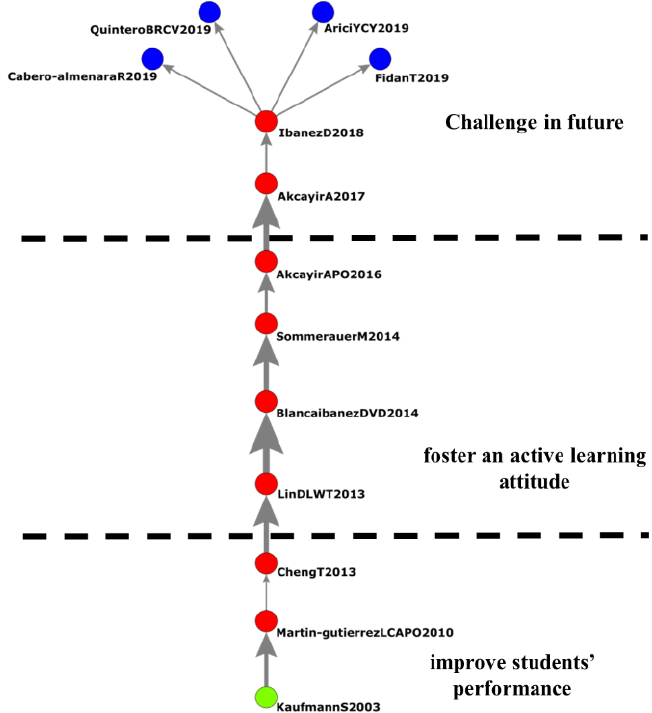
Figure 7. Application of AR technology in education.